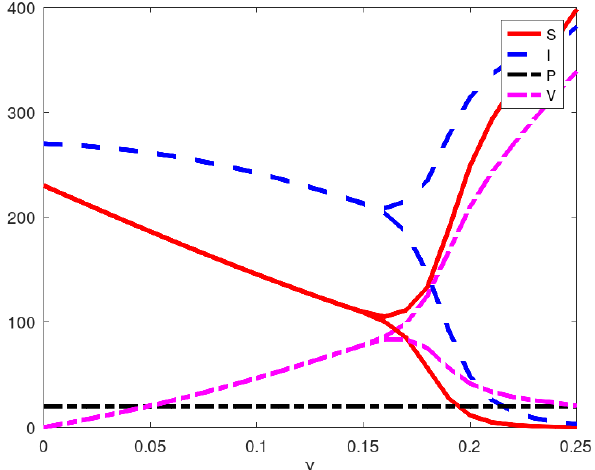
Figure 10. Hopf bifurcation diagram in terms of the parameter γ . Above the critical threshold γ † ≈ 0.15, the stable coexistence equilibrium (cid:98) E ∗ loses its stability, and the cycles are triggered. The two curves in the right portion of the diagram denote the peaks and the troughs of the oscillations. The other parameters are given in (23) and (28) with the initial conditions (22) and